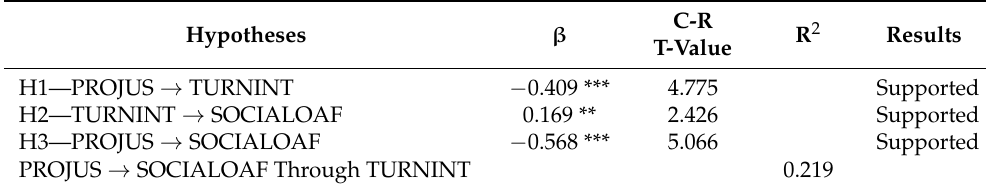
Table 4. Testing research hypothesis (developed by the authors).